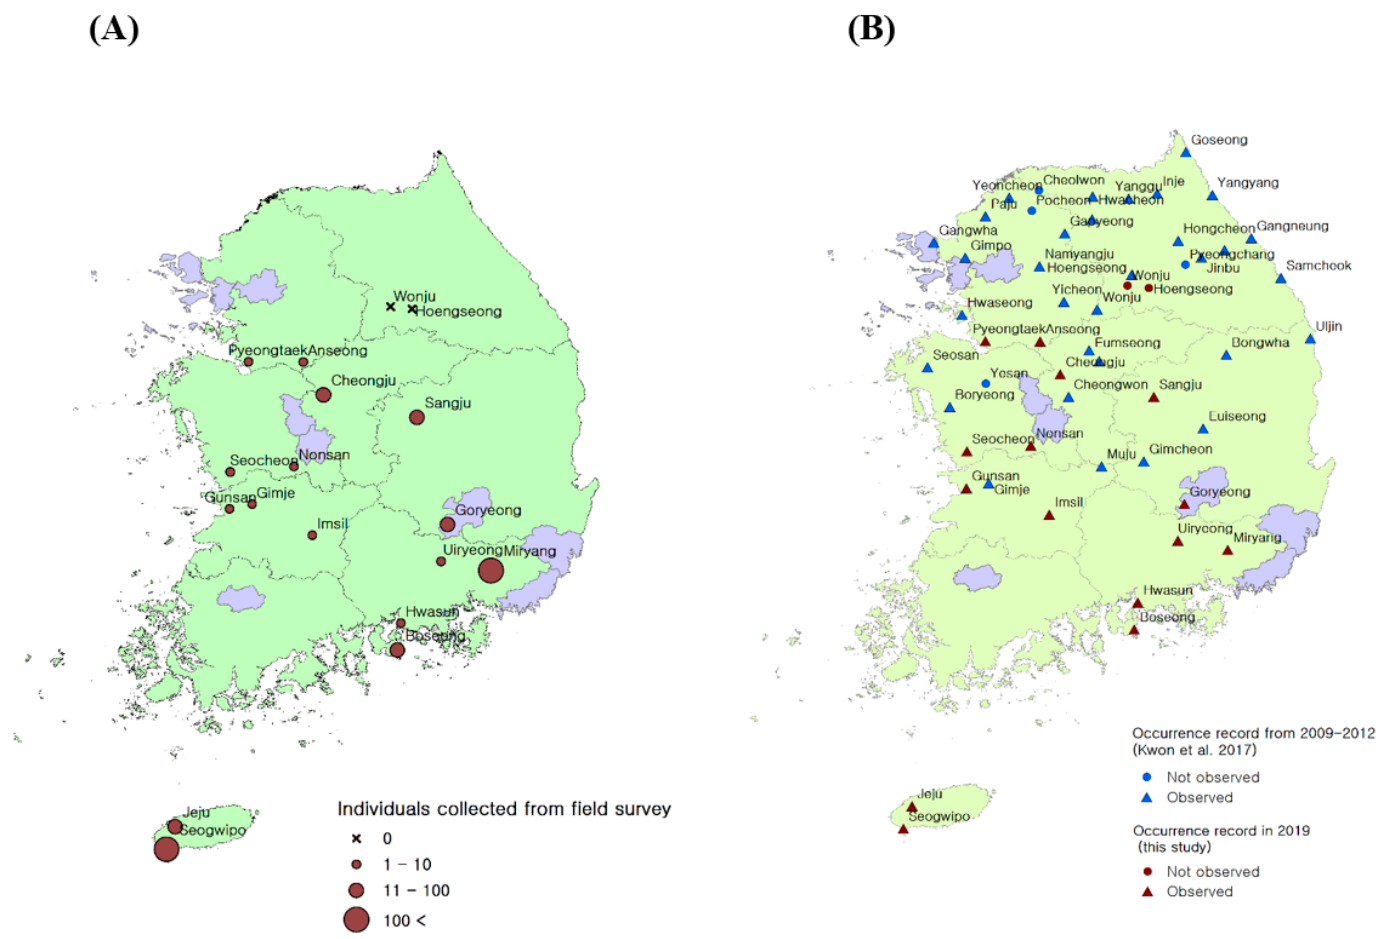
Figure 1. Field survey areas with the number of collected potato tuber moths ( A ), and the combined occurrence record of potato tuber moths in South Korea ( B ).